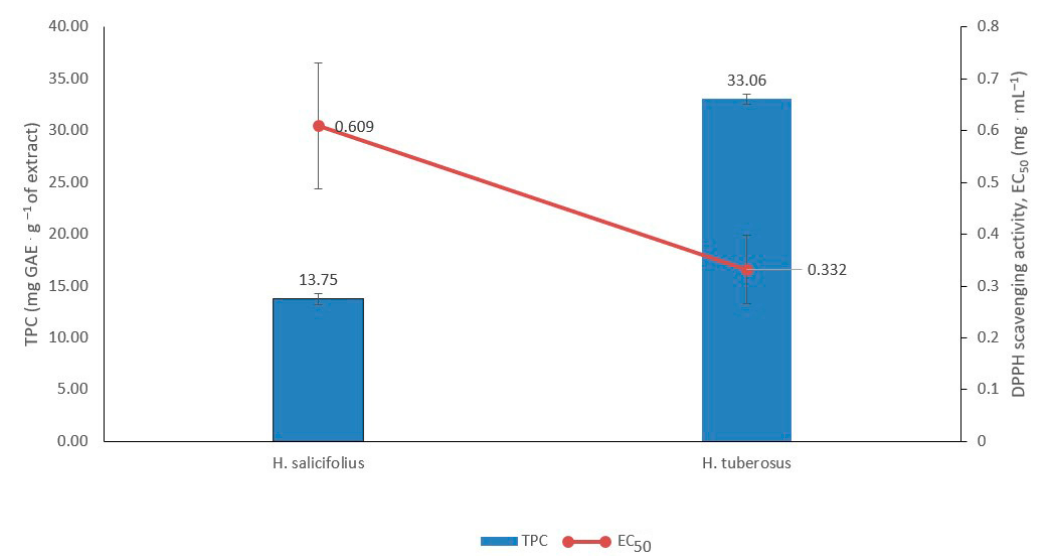
Figure 3. The total polyphenol content (TPC) in supercritical extracts obtained from H. salicifolius and H. tuberosus with water as a co-solvent (CO 2 + H 2 O extracts) together with their antioxidant activity. Mean values ± standard deviation were presented.